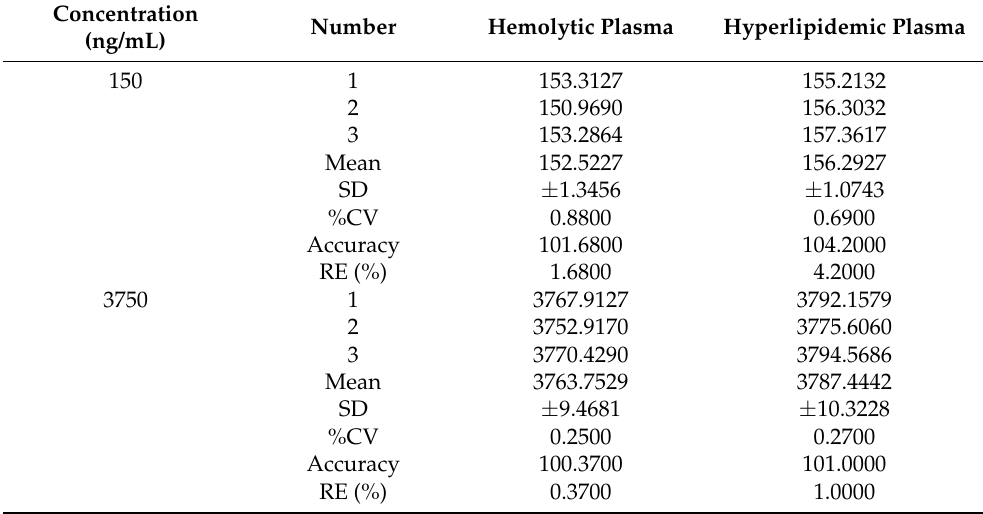
Table 1. ME of the method for determining contezolid in hemolytic and hyperlipidemic